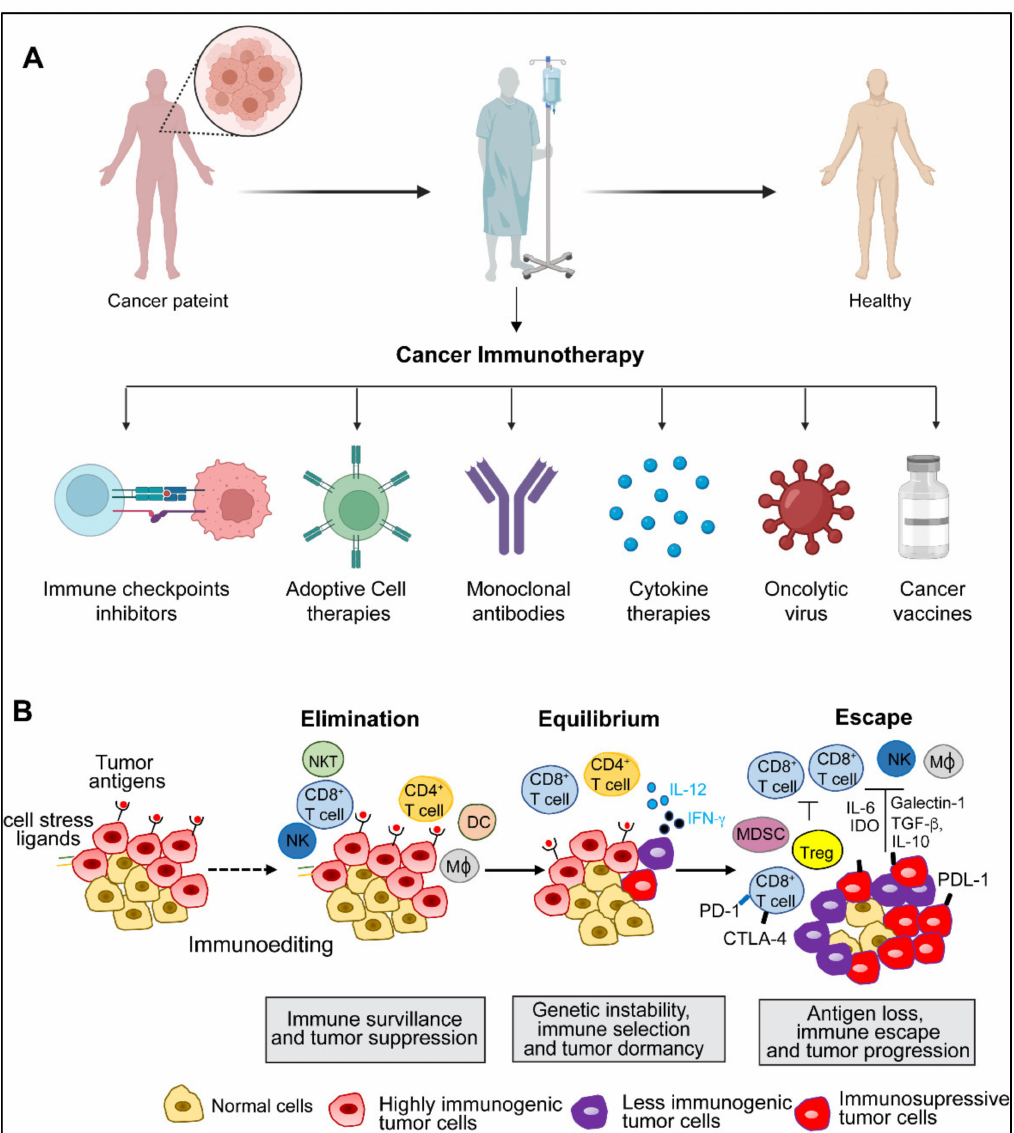
Figure 1. ( A ) Illustration depicting various immunotherapy approaches for cancer treatment. Created with BioRender.com. ( B ). Three steps of cancer immunoediting process: elimination, equilibrium, and escape. (Abbreviations: NK, natural killer; NKT, natural killer T; DC, dendritic cell; M Φ , macrophage; MDSC, myeloid-derived suppressor cells, IFN, interferon; IL, interleukin; CTLA-4, cytotoxic T lymphocyte-associated protein-4; PDL-1, programmed cell death ligand 1; PD-1, programmed death 1; Treg, T regulatory; IDO, indoleamine 2,3-deoxygenase; TGF- β , transforming growth factor- β